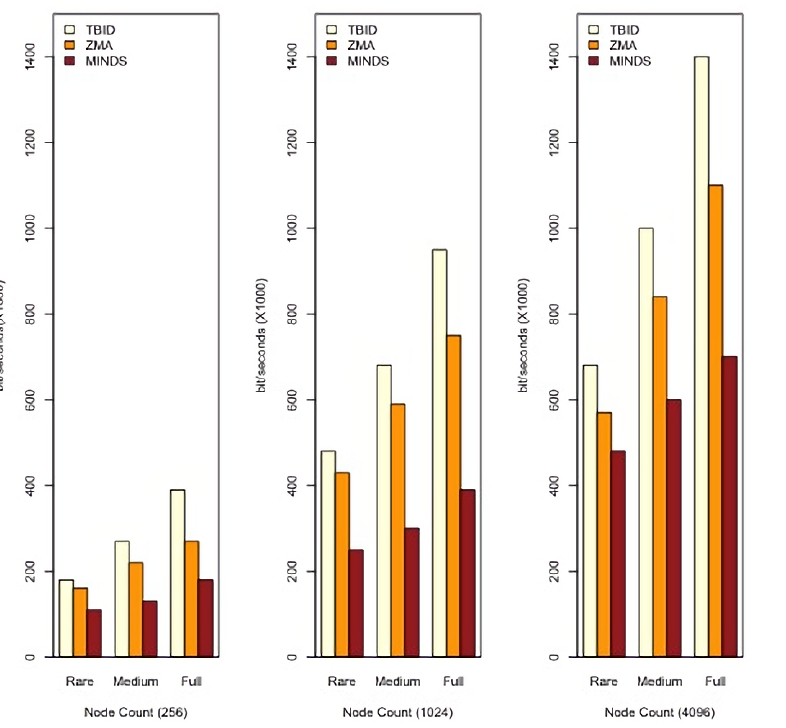
Figure 8. Transmitted network